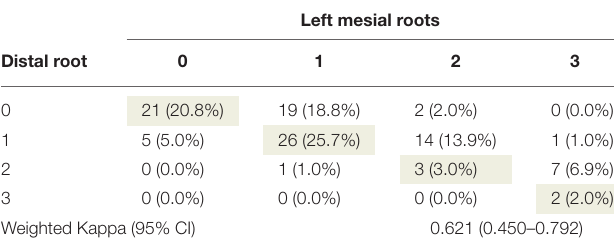
TABLE 4B | Apical position of root pairs within each tooth—left teeth.